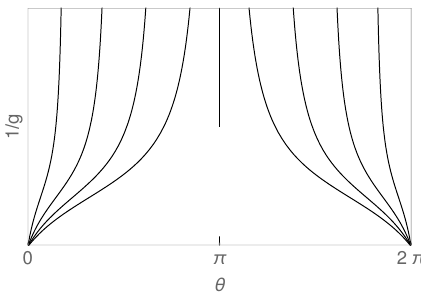
Figure 1. The renormalizaqtion group flow of the CP N ´ 1 model at large N for di ff erent initial values of θ . The distance scale ( „ 1 { T ) increases from top to